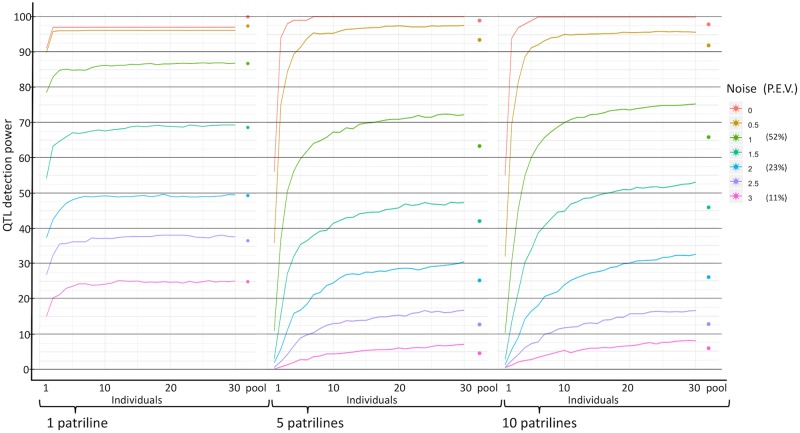
Power of QTL identification for different levels of polyandry (or monoandry).Similar to the simulations in Fig 4, except the queen of each colony has either one, five, or ten mates, i.e. one, five, or ten patrilines per colony (the central plot is identical to the one in Fig 4).